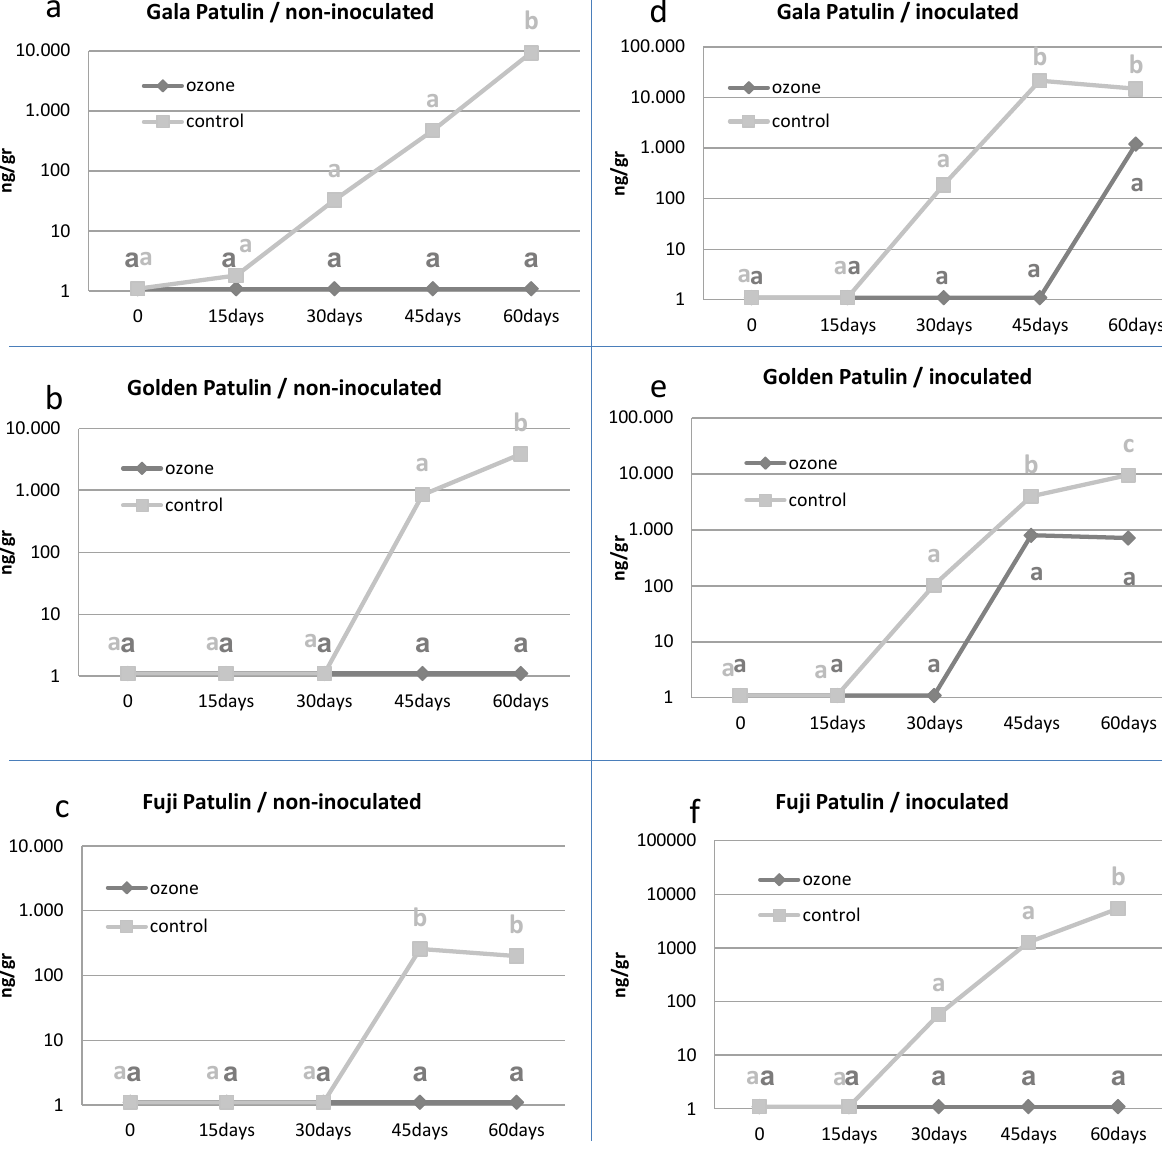
Figure 2. Mean patulin content in non-inoculated and Penicillium expansum inoculated apple fruits (‘Royal Gala’, ‘Golden Delicious’ and ‘Fuji-), either non-treated (a, b, c) or treated by ozone at 0.5μL L -1 (d, e, f) and stored at 1 ± 1°C in the dark. Means followed by the same letter are not significantly different (Fisher’s Least Significance Difference test (LSD, P =